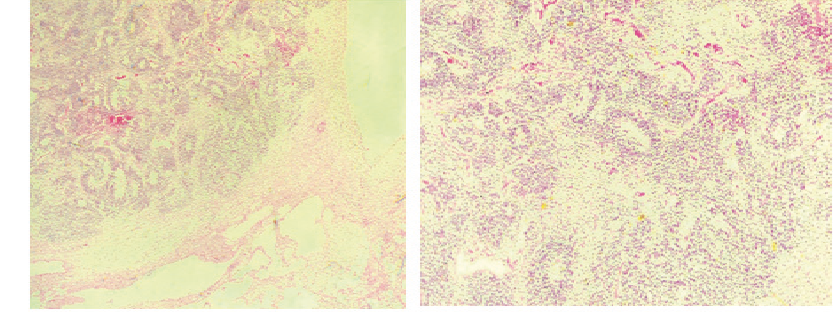
Figure3:Casethree:A20-year-oldwomanwithleftovarianmass.Sectionsof theovarianmassfroma20-year-old womanshowingimmature neuroectodermal elements forming tubules and solid masses (X10 and X